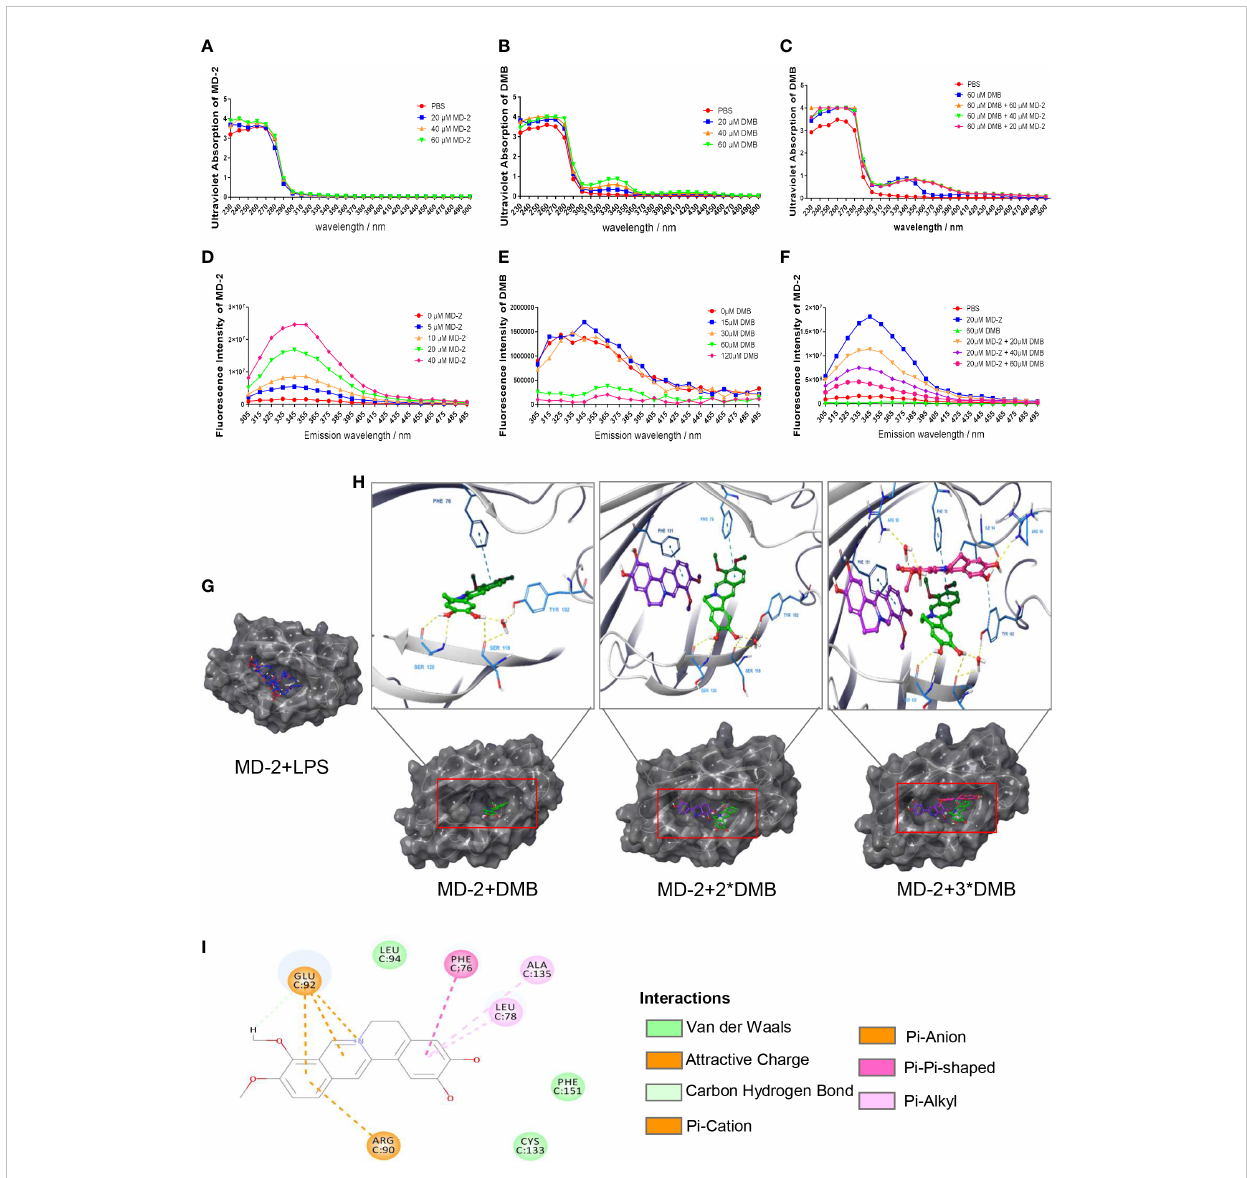
FIGURE 5 Spectroscopic analysis of the interaction between DMB and MD-2. (A) Ultraviolet absorption of MD-2 in different concentrations. (B) Ultraviolet absorption of DMB in different concentrations. (C) Ultraviolet absorption of DMB after co-incubation with MD-2 in different concentrations. (D) The fl uorescence emission spectrum of MD-2 in different concentrations after excitation at 280 nm. (E) The fl uorescence emission spectrum of DMB in different concentrations after excitation at 280 nm. (F) The fl uorescence emission spectrum of MD-2 co-incubated with DMB in different concentrations after excitation at 280 nm. (G) Molecular docking of MD-2 and LPS. (H) Molecular docking of MD-2 and DMB (1:1; 1:2, and 1:3). (I) DMB interacted with the phenylalanine at position 76 of MD-2 in a pi – pi T-shaped interaction. n =